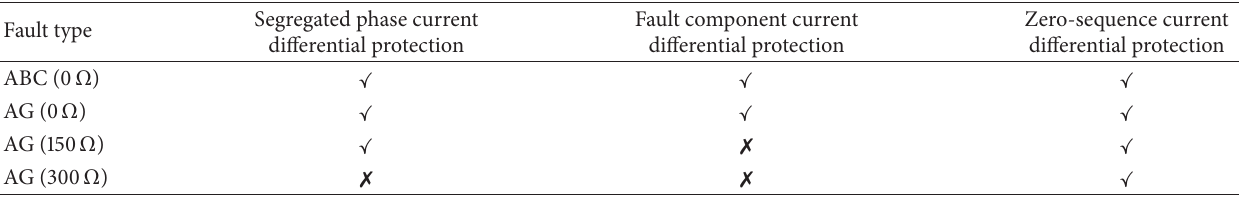
Table 3: Operation of current differential protection when the different fault occurred at the fault point F4.